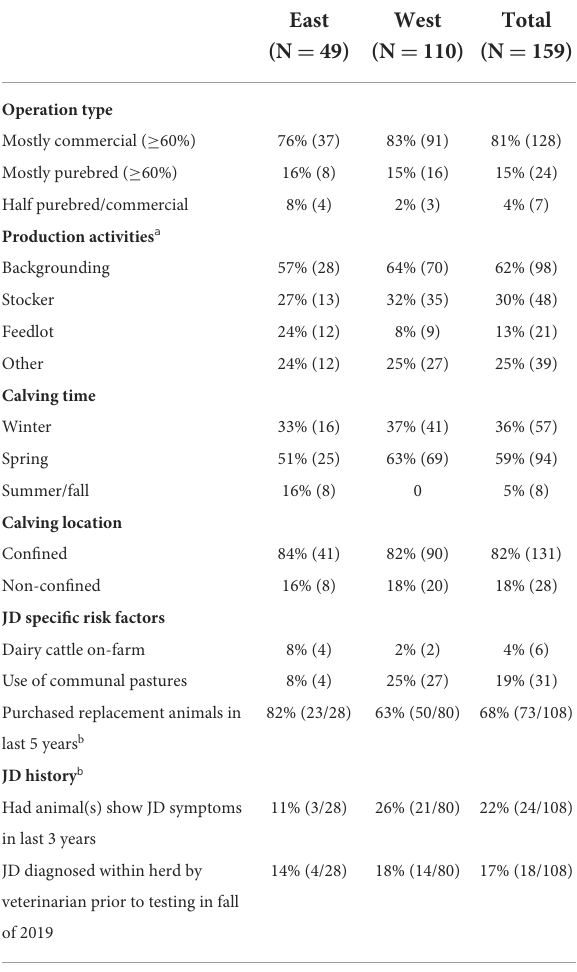
TABLE 1 Summary of baseline characteristics, management practices and JD history and risk factors for 159 study herds by region. Percentage (Number) of